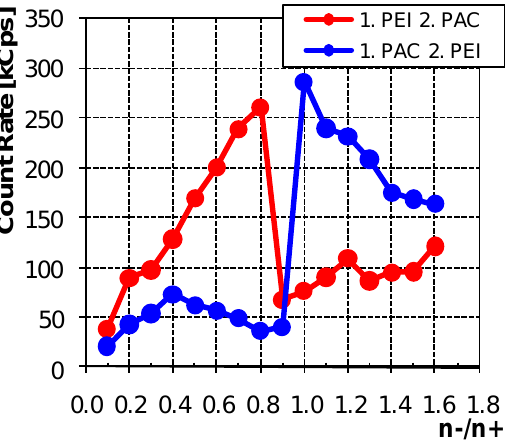
Figure 5. Count rate (CR) of PEI/PAC versus mixing